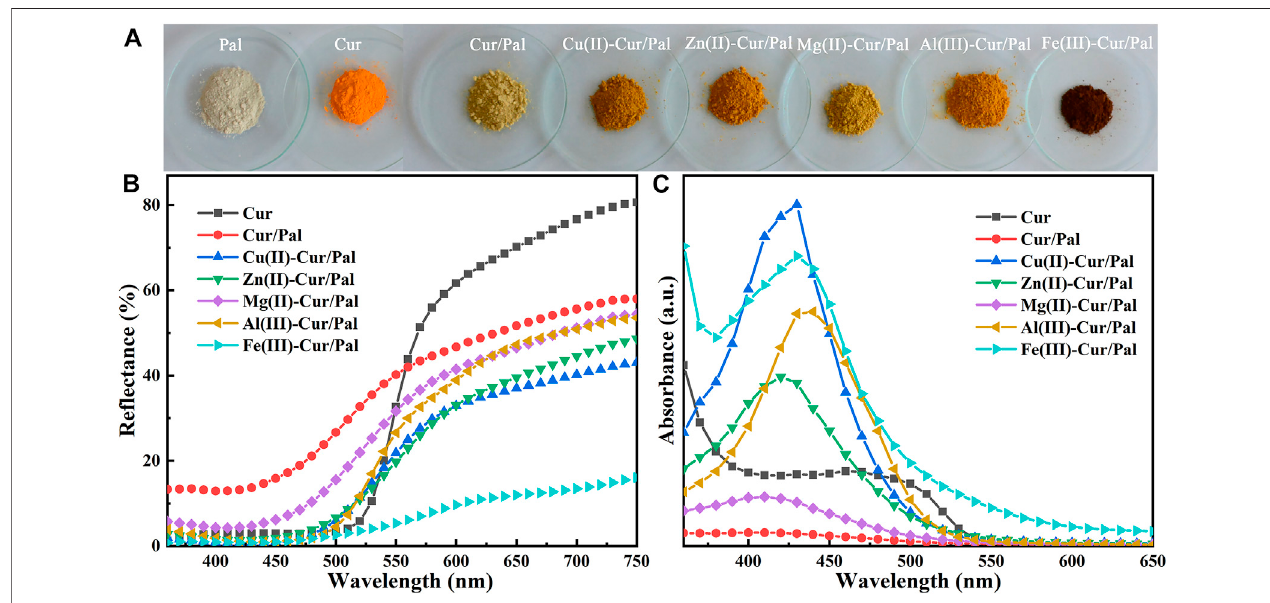
FIGURE 1 | (A) Digital images, (B) UV-vis diffuse re fl ectance spectra and (C) UV-vis spectra of Cur, Cur/Pal and metal ions-Cur/Pal hybrid materials.